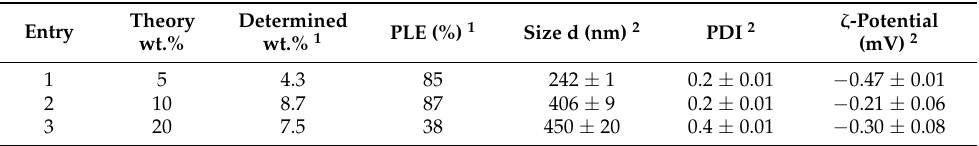
Table 2. Analysis of cytochrome C-loaded